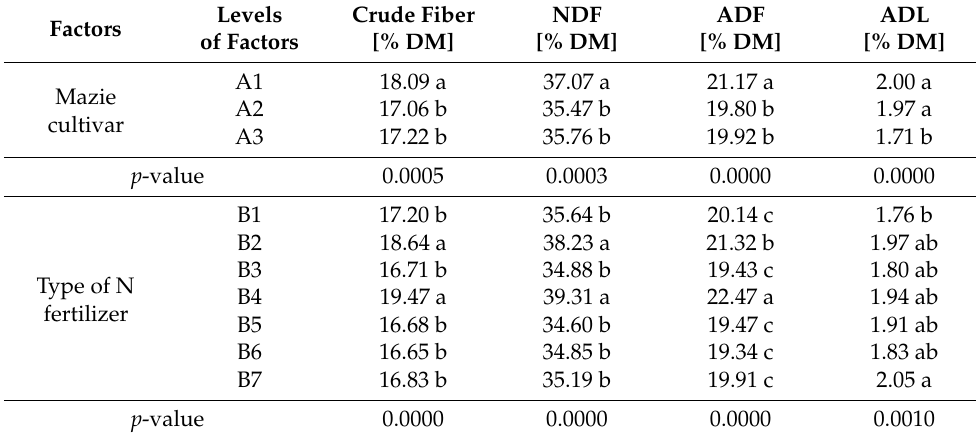
Table 8. Average values of structural carbohydrates for cultivars (A) and fertilizer